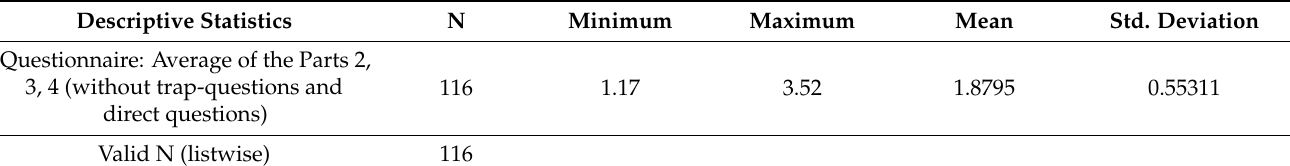
Table 4. Seismic vulnerability of WWTPs after analysis of a group of